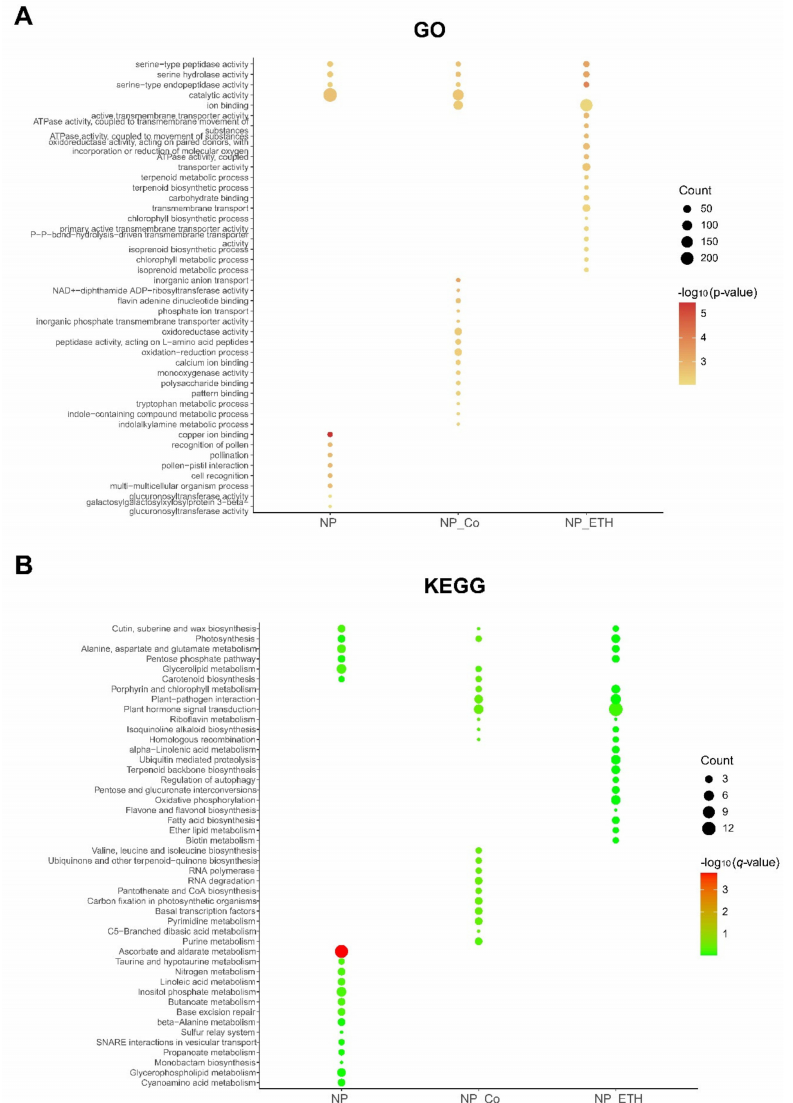
Figure 3. The bubble diagram shows that the DEGs of ( A ) GO and ( B ) KEGG were under three groups of treatment., Y-axis is the description of the function, and X-axis is the group name. CKP (normal Pi) as control, NP (Pi starvation), NP_ETH (Pi starvation and ethephon), NP_Co (Pi starvation and CoCl 2 ) were each experimental group point size variable represents the number of enriched genes. Color variables correspond to different − log10( q -value) or − log10( p -value)